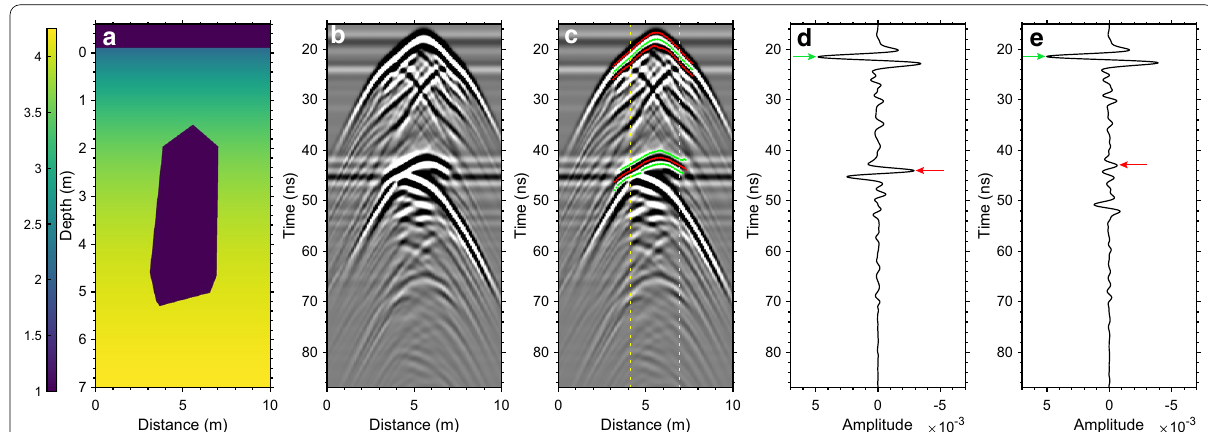
Fig. 2 Modeling radargram for typical lunar regolith that has an internal cavity. a The transmitted electromagnetic wave in our model is identical to the high-frequency LPR on the Yutu rover, and the bulk permittivity of typical lunar regolith is used in the model. The other model setups are introduced in "Method" section. b Simulated radargram. c Annotated positive and negative reflections following the phase reversals. d and e A-scan of reflections that are extracted along the dashed lines shown in panel c . The green and red arrows point to the positive and negative peak signals in the reflections,